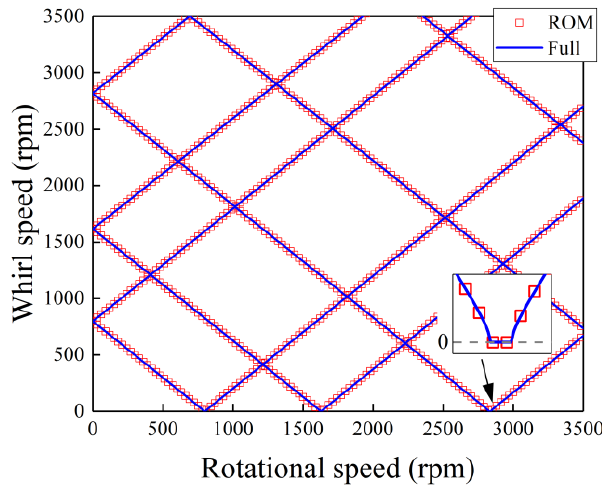
Figure 2. The whirl speed versus rotational speed in the rotating frame.